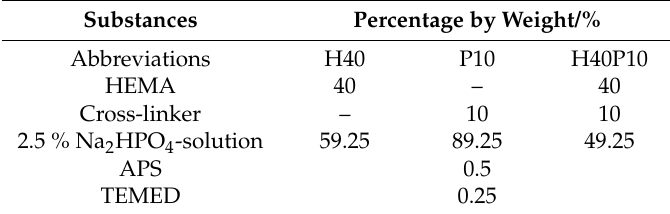
Table 1. Composition of the different liquid phases for composite formulations. H40 refers to 40 wt% HEMA monomer in the solution, whereas P10 corresponds to 10 wt% cross-linker addition. The combination of 40 wt% HEMA and 10 wt% cross-linker is abbreviated with H40P10. Substances Percentage by Weight/% Abbreviations H40 P10 H40P10